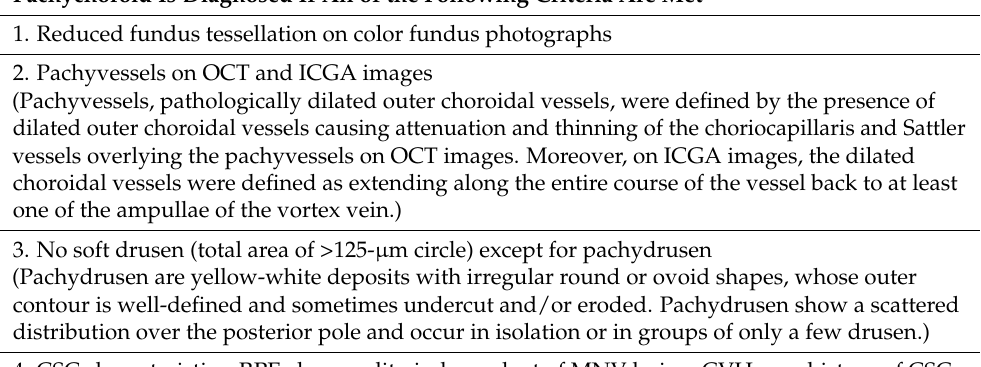
Table 6. Diagnostic criteria for